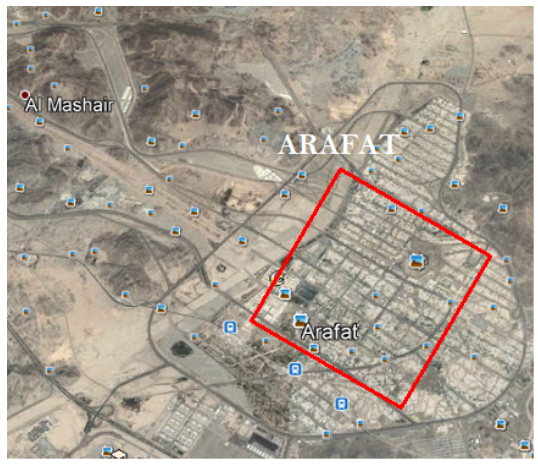
Figure 4. Square coverage area of 2 km × 2 km.